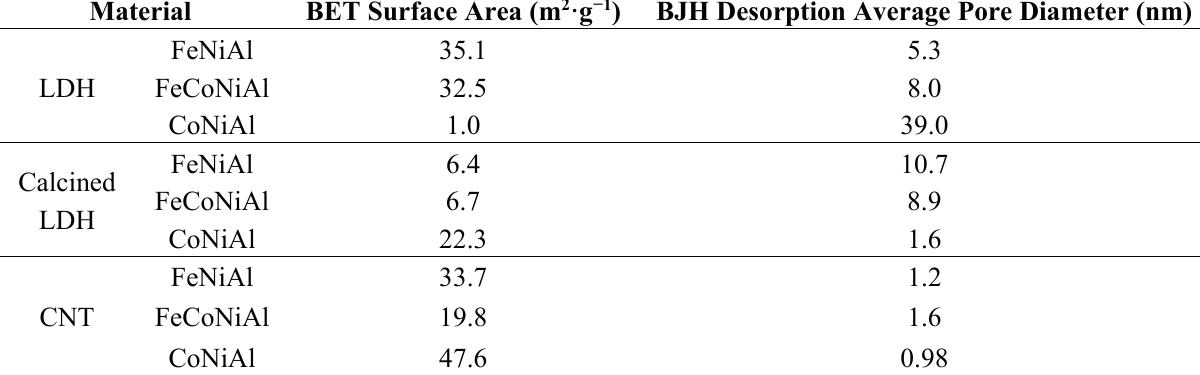
Table 1. Surface properties of FeNiAl, CoNiAl and FeCoNiAl LDH, calcined LDH and CNT over calcined